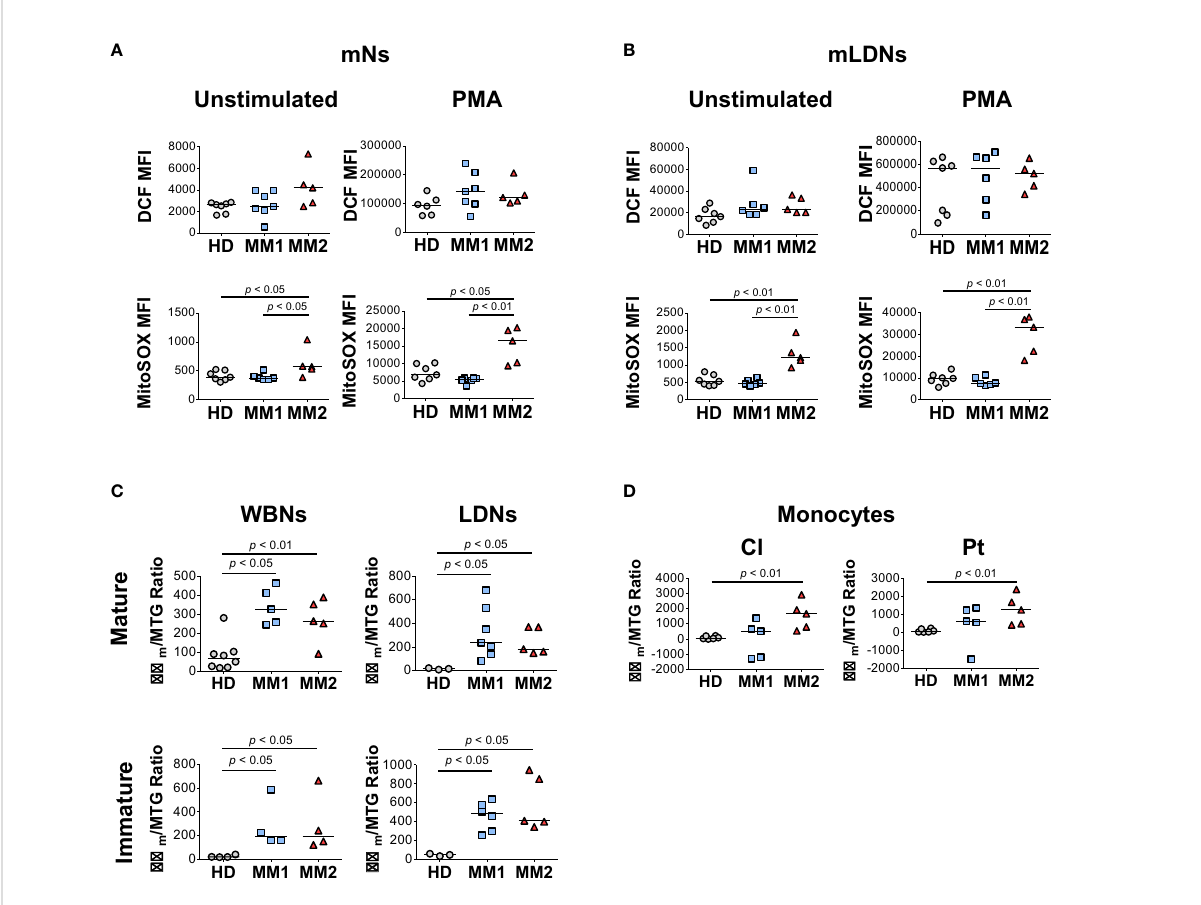
FIGURE 4 Myeloid cells obtained from MM2 patients exert altered functional activity. (A, B) Reactive oxygen species (ROS) production determined by dichlorodihydro fl uorescein (DCF) staining and mitochondrial superoxide production by MitoSOX ™ Red at baseline and upon stimulation with phorbol myristate acetate (PMA) in mNs (A) and mLDNs (B) of HD ( n =8) and MM1, ( n =5) and MM2 ( n =5) patients. (C, D) Mitochondrial membrane potential was determined using tetramethylrhodamine ethyl ester (TMRE) staining adjusted for mitochondrial mass as detected by MitoTracker ™ Green ( Dy m/MTG) on neutrophils (C) and monocytes (D) . MFI, median fl uorescent intensity; statistical analyses were performed using the Mann-Whitney rank-sum test with p values indicated. Bars represent median